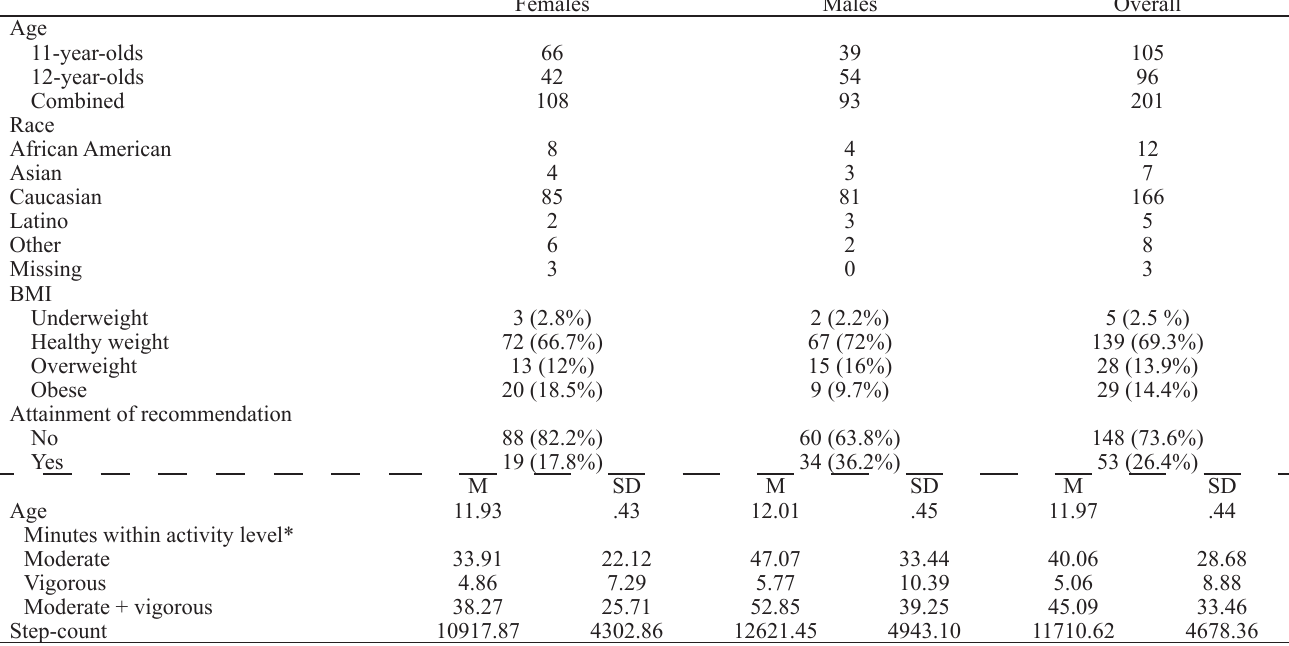
*Activity level was determined based on the Age-specific Freedson equation (4